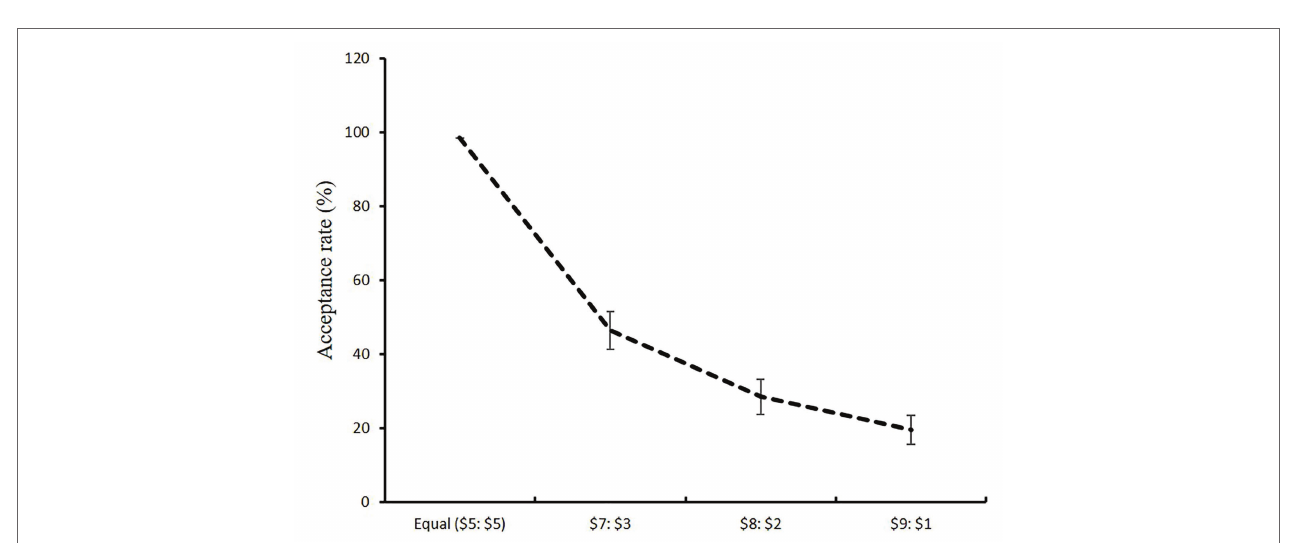
FIGURE 2 | Percentage of acceptance of the different